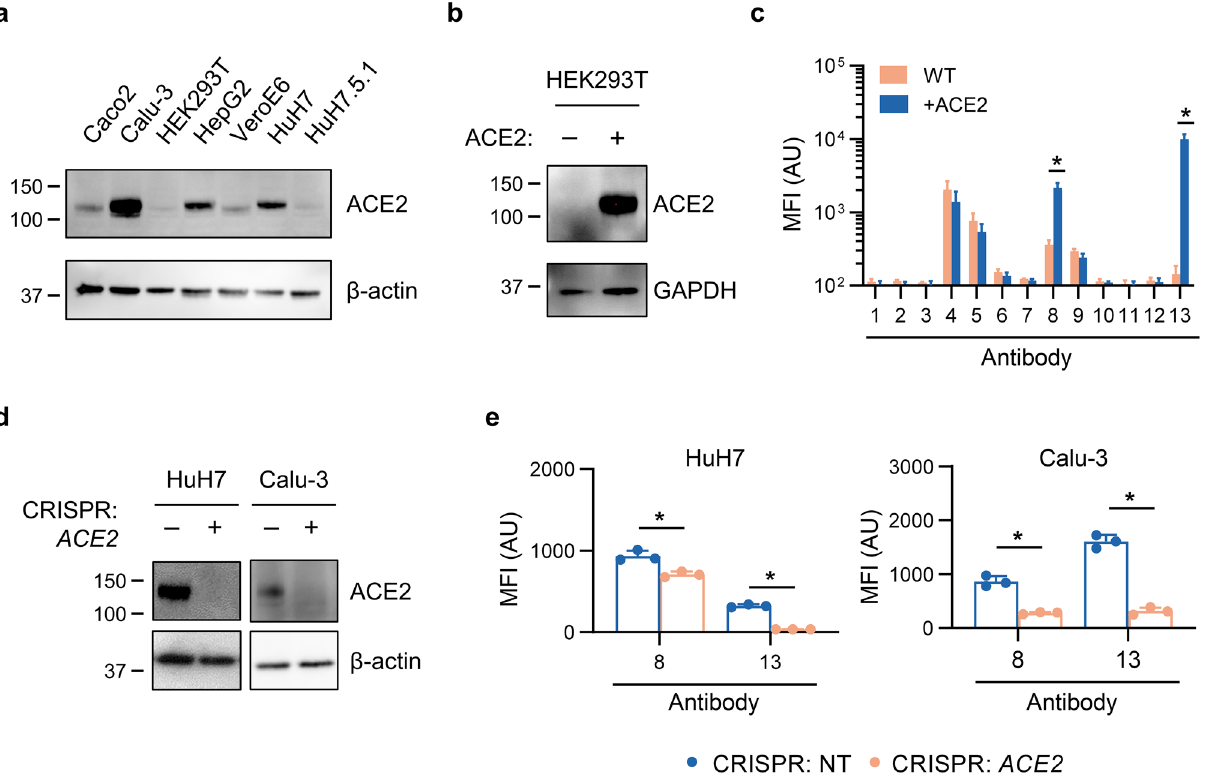
Figure 1. Validation of human ACE2 antibodies for flow cytometry. ( a ) Immunoblot of endogenous ACE2 against lysates from a panel of immortalized cell lines. ( b ) Immunoblot of heterologous overexpressed ACE2 in HEK293T cells. ( c ) Quantification of surface ACE2 mean fluorescence intensity (MFI) by flow cytometry with a panel of 13 commercial antibodies against parental and ACE2-overexpressing HEK293T cells. Antibody sources are listed in Table 1. ( d ) Immunoblot of endogenous ACE2 in HuH7 and Calu-3 cell lines generated by CRISPR with either a nontargeting or ACE2 -targeting gRNA. ( e ) Quantification of mean fluorescence intensity (MFI) of endogenous ACE2 at the cell surface by flow cytometry in HuH7 and Calu-3 cell lines generated by CRISPR with either a nontargeting or ACE2 -targeting gRNA, comparing the two commercial antibodies that exhibited specific ACE2 staining in 1C. Asterisk indicates p < 0.05 by two-tailed Student’s t test. Error bars represent standard deviation. All immunoblots for ACE2 were performed with GeneTex